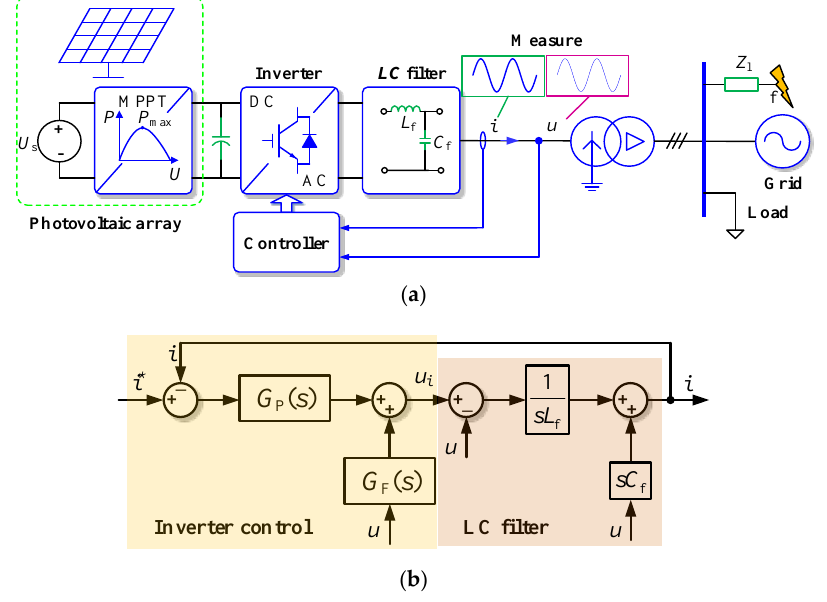
Figure 2. A grid-connected VSC-based renewable energy: ( a ) schematic diagram; ( b ) control block diagram.